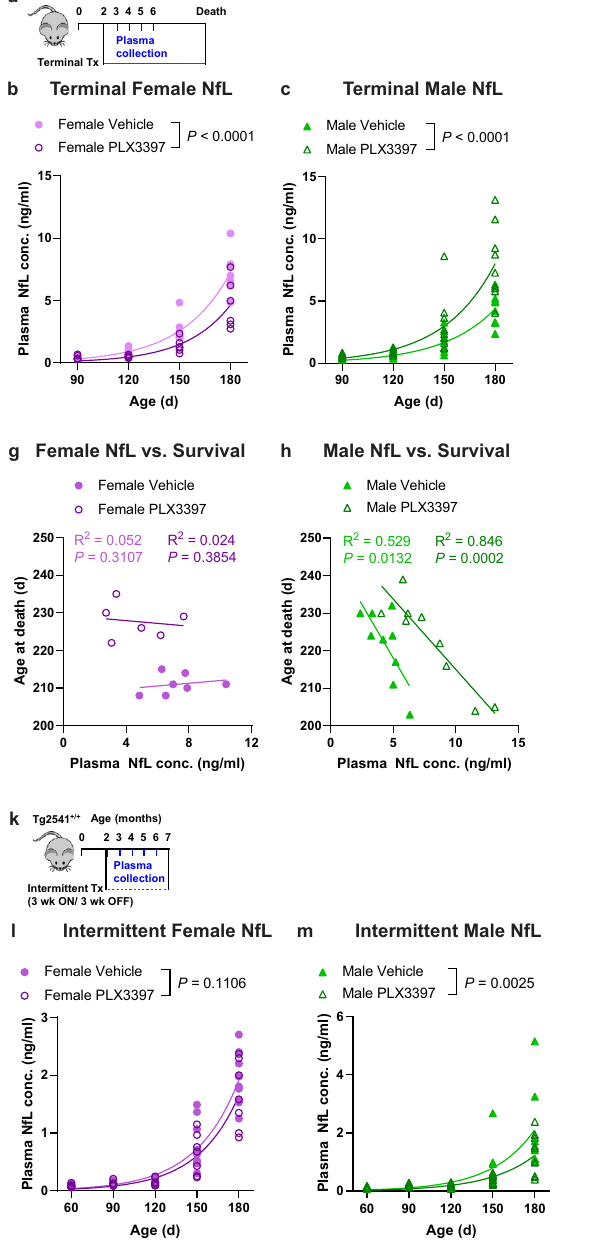
Fig. 4 | Plasma NfL levels are reduced by PLX3397 in female Tg2541 mice and increased in male mice. a Schematic of terminal PLX3397 treatment (275mg/kg oral)of Tg2541micefrom 2 mo of ageuntil death and blood plasma collected at3, 4, 5, and 6 mo of age. b , c Plasma concentration of NfL in female ( b ) or male ( c ) Tg2541micetreated withvehicle or PLX3397. Groupswerecomparedbynonlinear regression. d SchematicofterminalPLX3397treatmentofTg2541micefrom2.5mo of age until death, following inoculation of K18 tau fi brils into the midbrain (hindbrainregion)at2.5moofage,andbloodplasmacollectedmonthlythereafter until death. e , f Plasma concentration of NfL in female ( e ) or male ( f ) Tg2541 mice inoculated with K18 tau fi brils followed by terminal treatment with vehicle or PLX3397,plottedoverdayspost-inoculation(dpi). g , h Correlationplotsforplasma NfLconcentrationand survivalin female ( g ) or male ( h ) Tg2541mice. Each symbol represents an individual mouse. i , j Correlation plots for brain concentration of PLX3397andNfLconcentrationinthe( i )forebrainsor( j )hindbrainsofTg2541mice receiving midbrain inoculation with diluent. Each symbol represents the forebrain